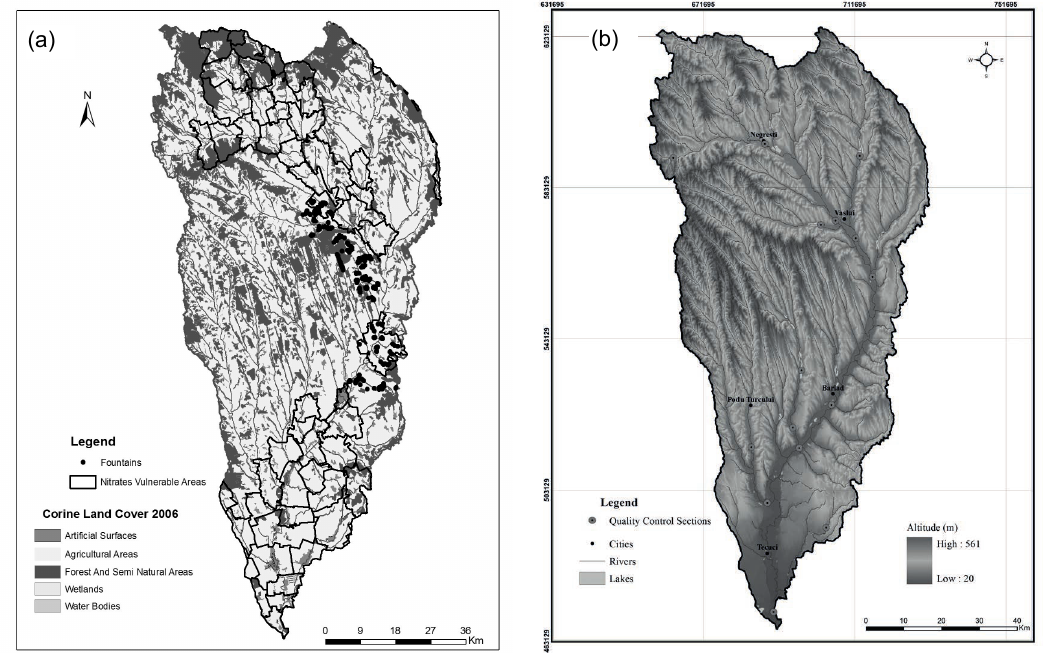
Fig. 2 Study area covered with portable sonde: domestic wells (a) and control sections from monitoring network (b) within the Barlad Basin.